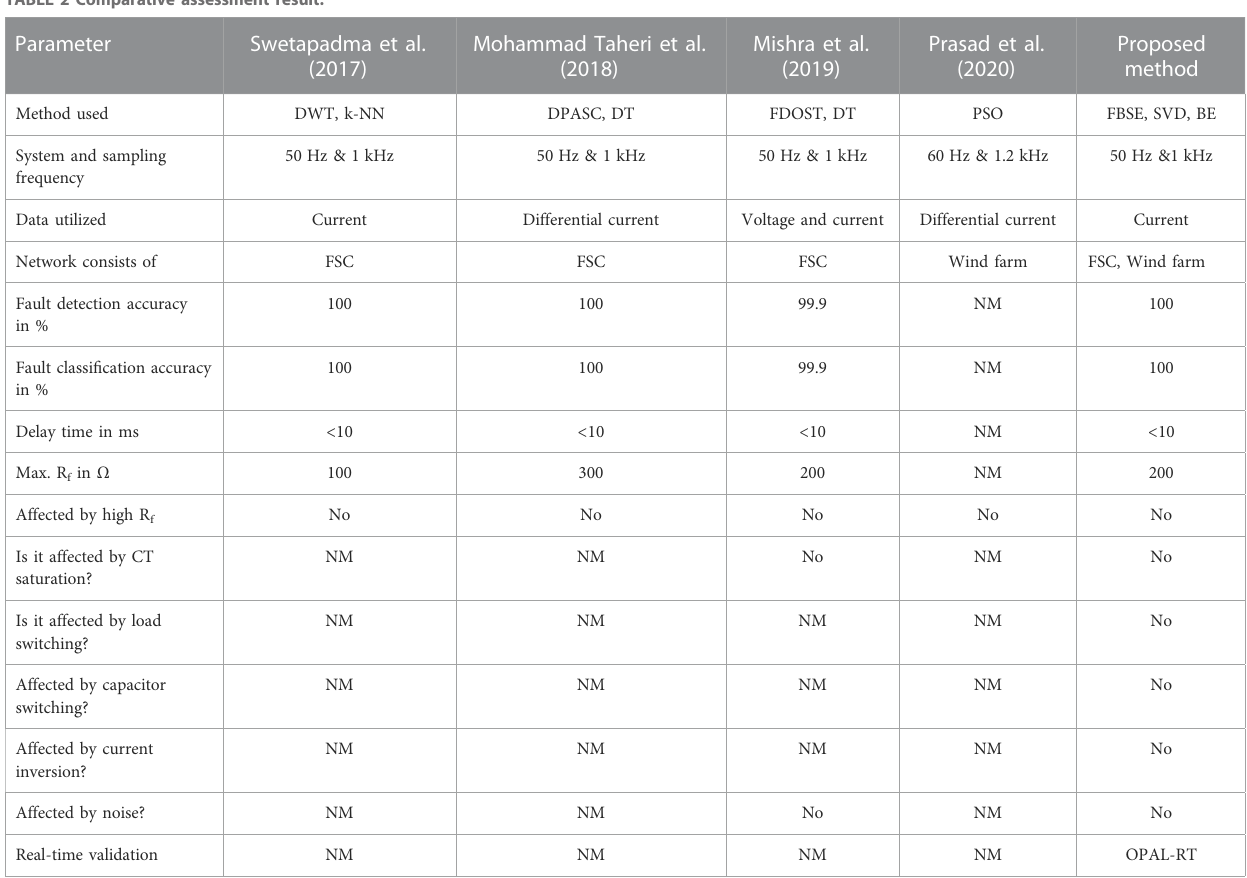
TABLE 2 Comparative assessment result.